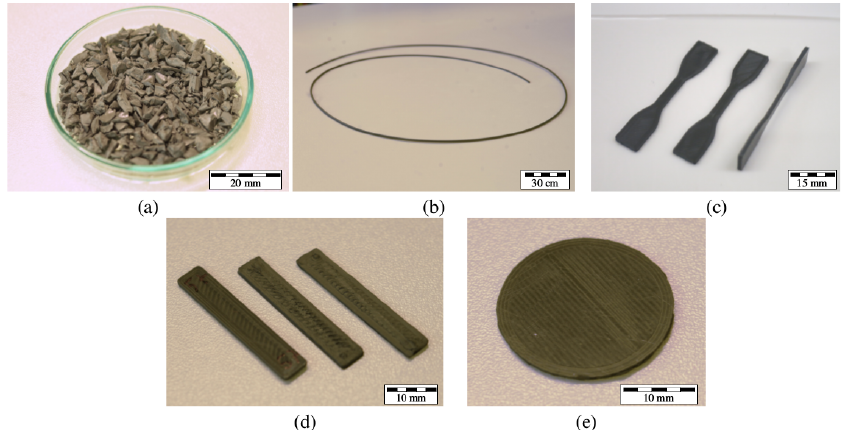
Figure 1. ( a ) The acrylonitrile butadiene styrene (ABS)–Steel composite feedstock after kneading and drying. ( b ) The extruded composite filament. ( c ) Tensile test samples. ( d ) Flexural test specimens. ( e ) A sample for magnetic